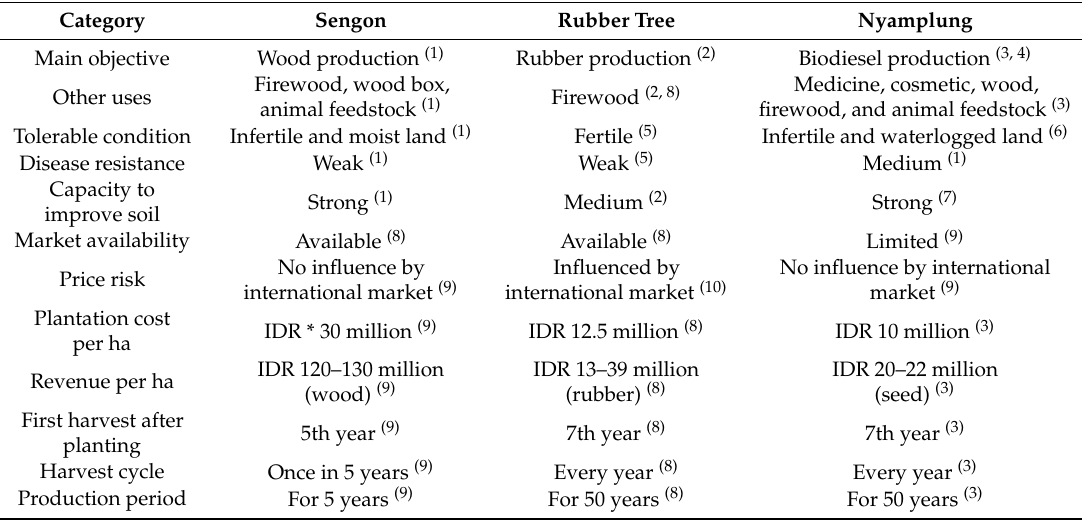
Table 1. Characteristics of three potential species for restoration of degraded lands in Buntoi